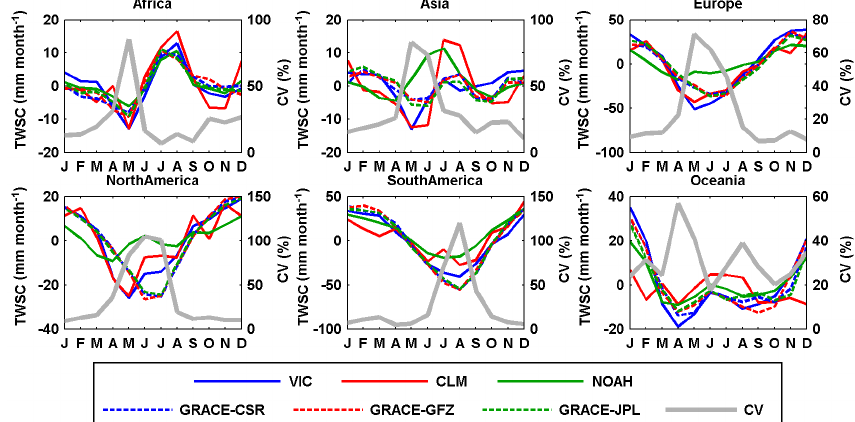
Figure 9. Seasonal cycles of TWSC from different products over the six continents for 2003–2010. TWSC is first normalized and then the CV (%) is calculated. The same is true for Fig. 10.